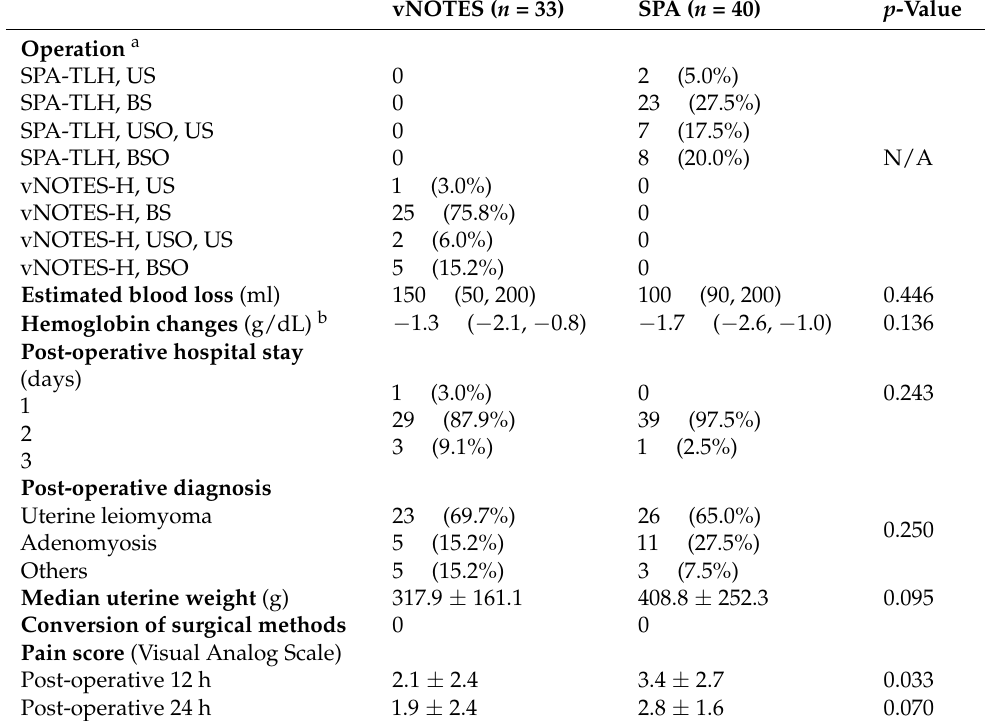
Table 2. Surgical and post-operative outcomes of the vNOTES and SPA